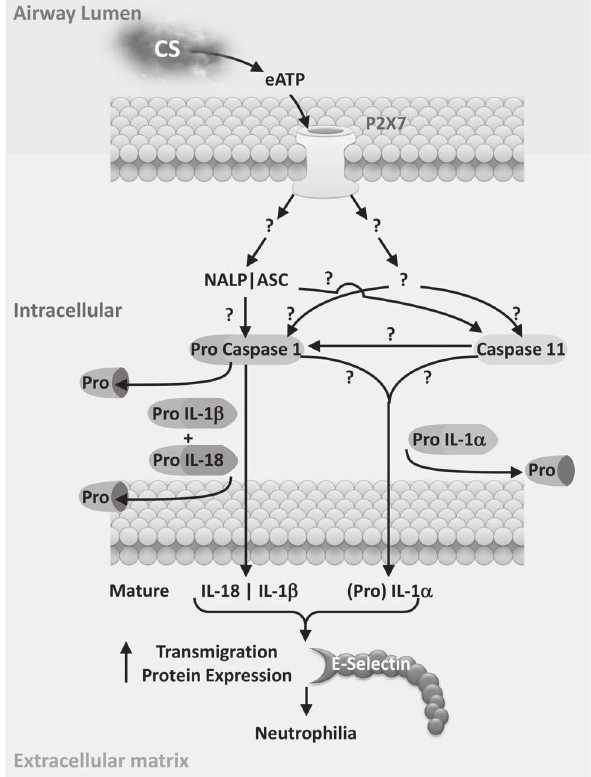
Figure 6. Schematic representation of the signalling cascade following CS-induced activation of the P2X 7 channel in the lung (Drawn by Dr E Dubuis). We hypothesise that CS exposure leads to the release of extracellular ATP which activates P2X 7 receptor, and this in turn triggers a signalling cascade involving the assembly of the NALP3/ASC inflammasome and recruitment of (pro)-caspase 1. Pro- Caspase 1 either auto-processes itself to the mature, active form or is cleaved by caspase 11. This functional inflammasome is essential for the release of mature, active IL-1 b /IL-18, but not IL-1 a which stimulates some of the production of proteins involved in the transmigration of neutrophils, like E-selectin. Another component of the P2X 7 receptor signalling cascade triggers the caspase 1 and/or caspase 11 dependent release of IL-1 a . This cytokine also induces the production of proteins involved in the recruitment of a portion of the neutrophils observed in this model system. Interrupting steps involved in both signalling pathways i.e. at the P2X 7 receptor or via caspase 1/11 leads to a complete block of transmigration protein production and neutrophilia.